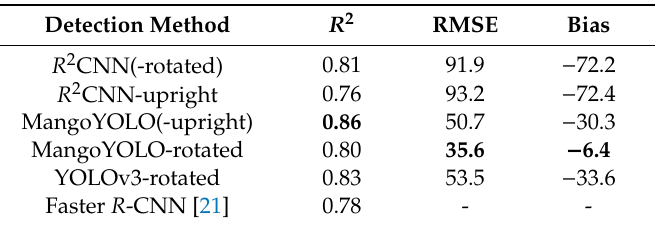
Table 5. Comparison of panicle assessment methods on the test image set (from [21]) in terms of the R 2 and RMSE between machine vision panicle (sum of two sides of a tree) count on images (two per tree) and in-field human counts of panicles per